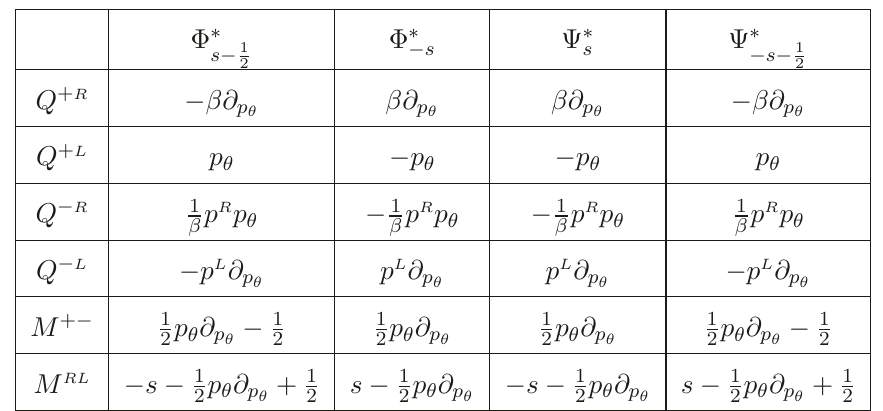
Table 2 . Realization of supercharges (B.7) , (B.8) on superfields (3.16) – (3.18) . Realization